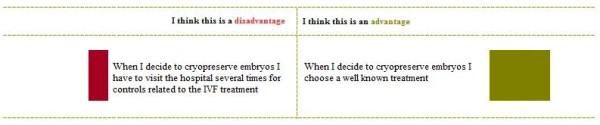
Example of the summary of given ratings. The red box in the column with disadvantages (left side of the figure) represents the extent to which the rated disadvantage is important in the decision whether or not to opt for a certain FP option (in this case cryopreservation of embryos), as indicated by the patient herself in the previous step (Figure 1). The green box in the column with advantages (right side of the figure) represents the extent to which the rated advantage is important in the decision whether or not to opt for a certain FP option (in this case cryopreservation of embryos), as indicated by the patient herself in the previous step (Figure 1) [18].